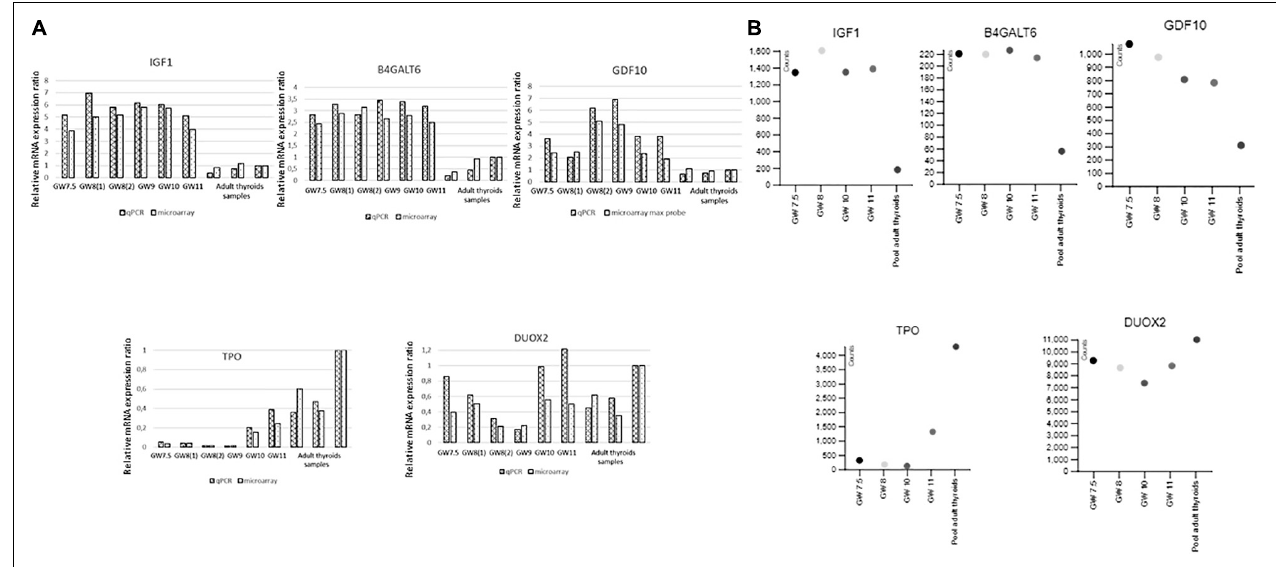
FIGURE 5 | (A) Validation by qRT-PCR of the microarray data for IGF1, GDF10, B4GALT6, TPO, and DUOX 2. Ratios of gene expression in qRT-PCR and microarray experiments for different embryonic thyroid samples compared to a pool of adult thyroids (Clontech). Samples are labeled as in Supplementary Table 1 : GW 7.5: ET2, GW 8(1): ET4, GW 8(2): ET6, GW 9: ET8, GW 10: ET9, GW 11: ET11 adult thyroid samples: BO148N BO147N and CLONT (GW: gestational week). (B) Validation by RNAseq of the microarray data for IGSF1, FGF 12, TSHR, DUOX, and SLCA5A. Expression of genes in counts (counts per 20 million of reads) from RNAseq experiments performed on four fetal thyroid samples and on the pool of adult thyroids (Clontech), labeled as in Supplementary Table 1 : GW 7.5: ET 3, GW 8: ET 5, GW 10: ET 10, GW 11: ET 11 (GW: gestational